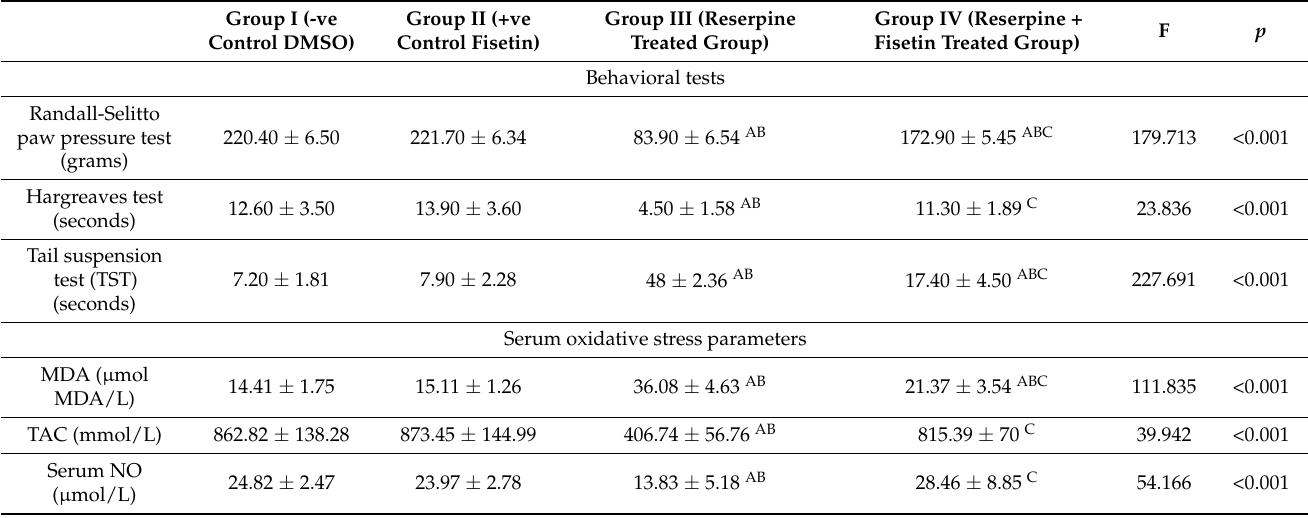
Table 1. Behavioral tests and serum oxidative stress parameters of all animal studied